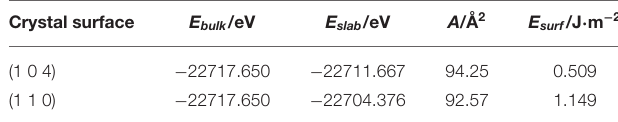
TABLE 2 | Surface energies of different ilmenite